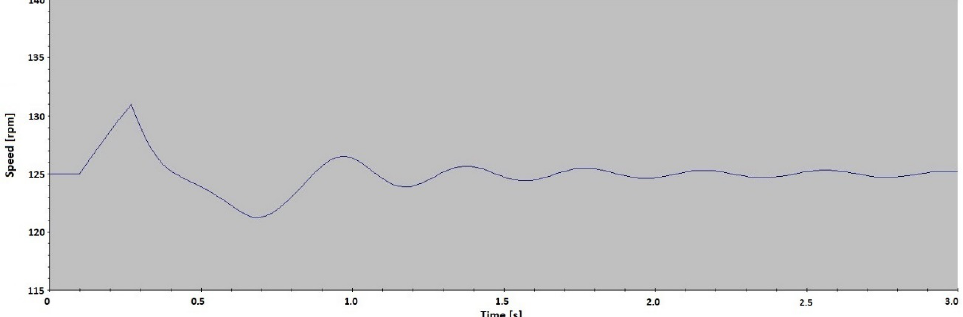
Figure 22. Simulation results of speed of Generator 2 during the three-phase fault with the fault duration of 170 ms.